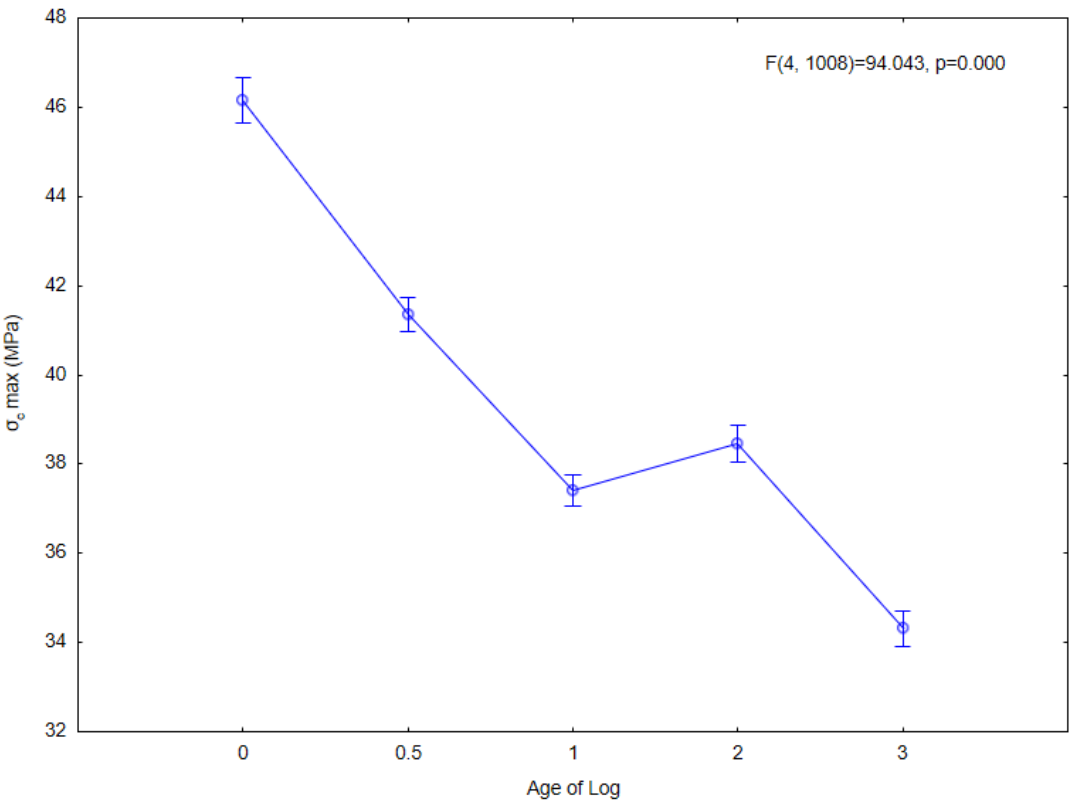
Figure 7. Statistical evaluation of the effect of log age on compressive strength using ANOVA.